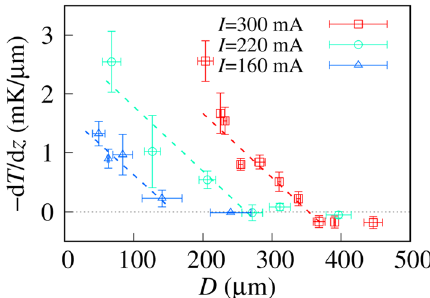
Figure 4. The distribution of upward temperature gradient, with local temperature gradient estimated from the angular momentum distribution of the Ch-LC droplets. The current values applied to the Au thin-film electrode are 300, 220, and 160 mA. The dashed lines are best-fit lines using linear functions. The slope is 0.01 ± 0.003 mK/µm 2 and is independent of I . Each data point is averaged over more than 3 samples.